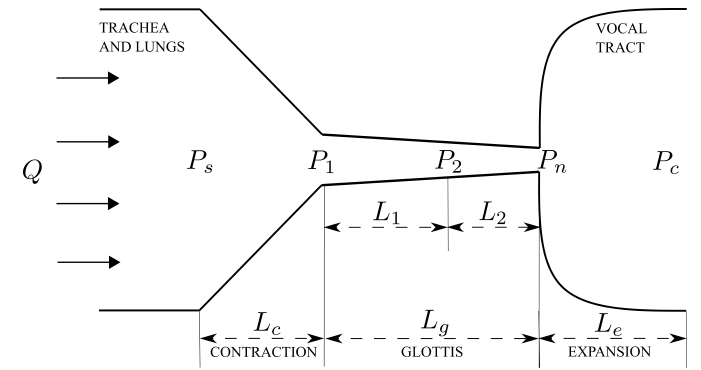
Figure 1. Schematic of the vocal folds model. Table 1. Definition of the notations in Figure